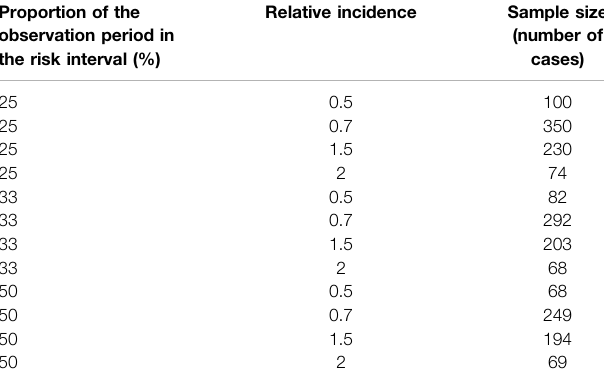
TABLE 3 | Sample size estimation. Proportion of the observation period